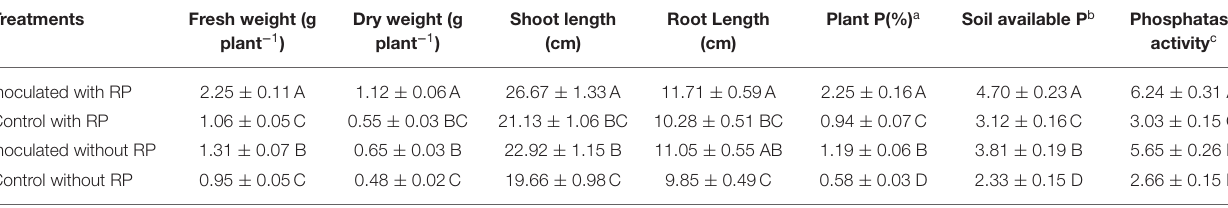
TABLE 2 | Evaluation of PSB on wheat grown in soil amended with unavailable form of P under controlled conditions.